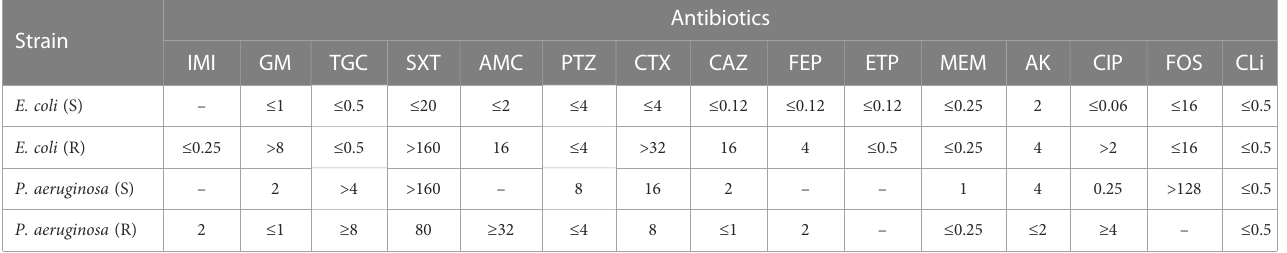
TABLE 3 Antimicrobial resistance pro fi le of Gram-negative strains. Data are reported as m g/ml.